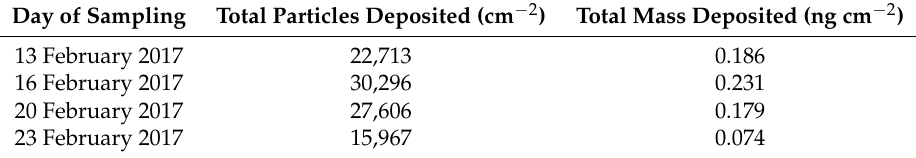
Table 6. Air Liquid Interface system: mass and total number deposition during the CARE